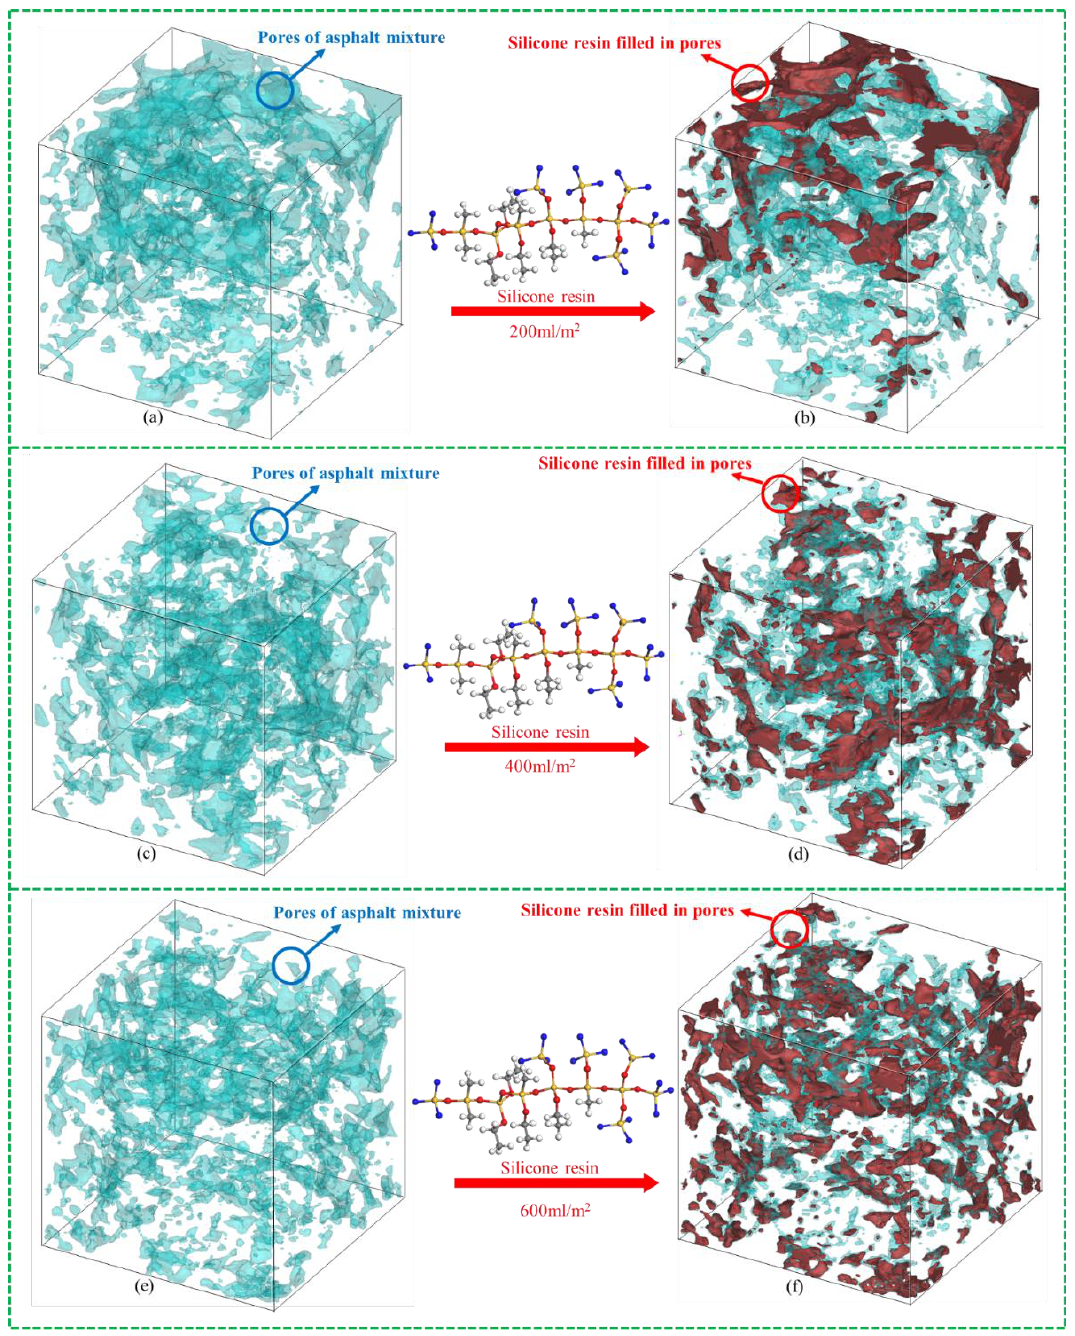
Figure 11. 3D reconstruction of pores and silicone resin at dosages of 200 mL/m 2 : ( a ) and ( b ); 400 mL/m 2 : ( c ) and ( d ); and 600 mL/m 2 : ( e ) and ( f ).